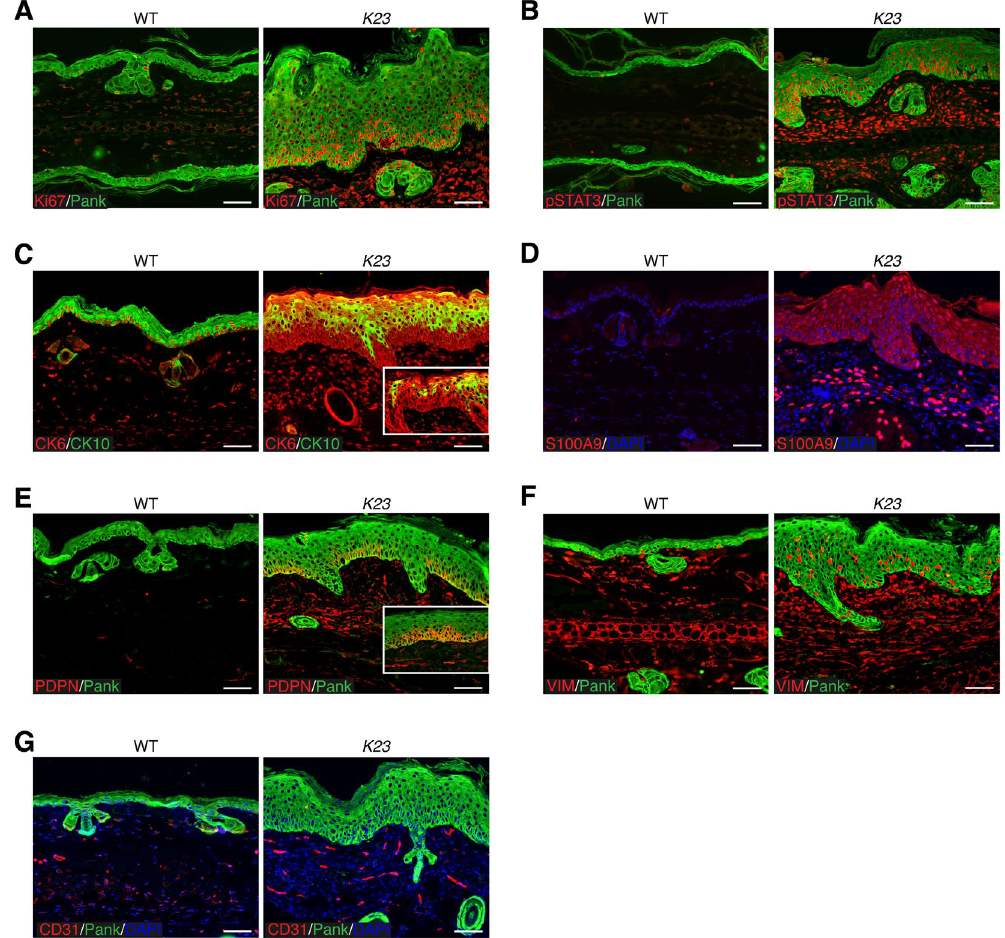
Figure 2. Hallmark features of PS reproduced in the skin of K23 mice. ( A , B ) Increased expression of Ki67 ( A ) and pSTAT3 ( B ) in the ears of K23 mice 6 weeks after TAM treatment. Pan-Keratin staining (PanK, green) showed increased epidermal keratinocytes in psoriatic lesions of K23 mice. ( C ) Increased expression of CK6/ CK10 in the ears of K23 mice 6 weeks after TAM treatment. Notice areas showing co-expression CK6 and CK10 in the ear of K23 mice (inset, arrowheads). ( D – F ) Immunofluorescence staining of ear of K23 mice 20 weeks after TAM treatment. Increased expression of S100A9 ( D ), podoplanin (PDPN) ( E ), and vimentin (VIM) ( F ) in the epidermis of K23 mice ears when compared to WT controls. ( G ) Increased umber of CD31 + vessels in the ear of K23 mice when compared to controls. Scale bars, 50 μ